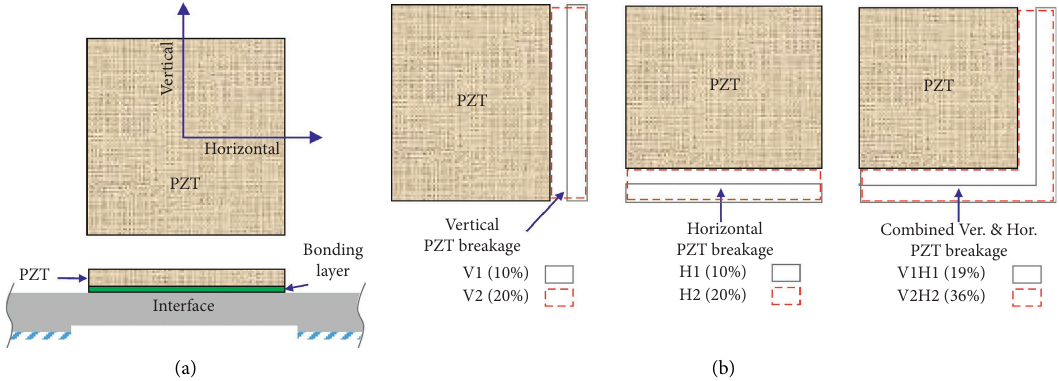
Figure 21: Simulation of PZT breakage cases for the smart interface. (a) Intact. (b) Breakage cases: V1, V2, H1, H2, V1H1,